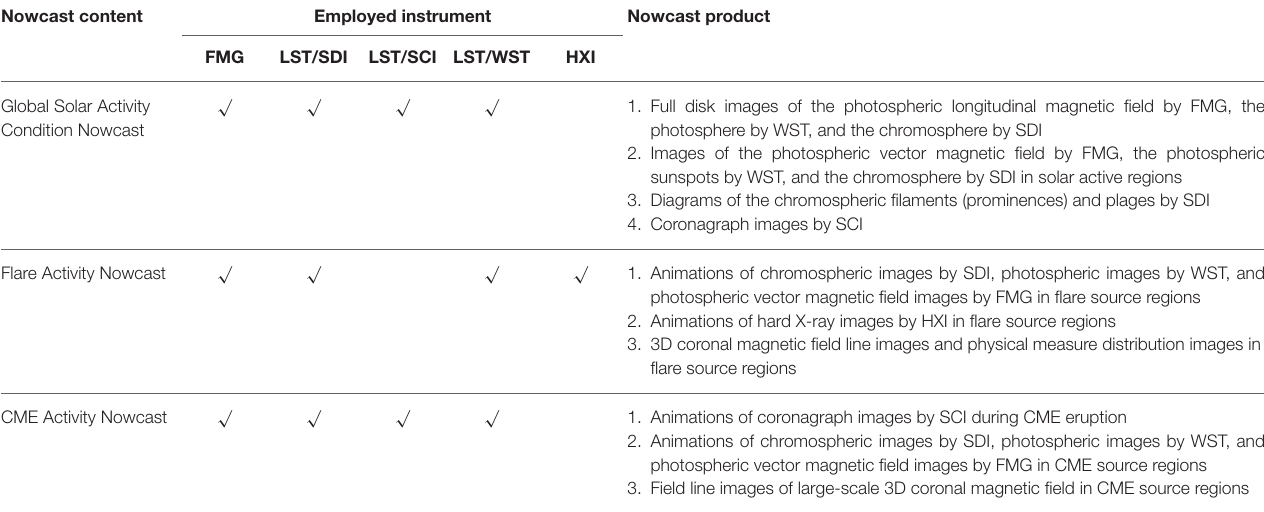
TABLE 2 | Solar activity nowcast products based on the ASO-S observations. Nowcast content Employed